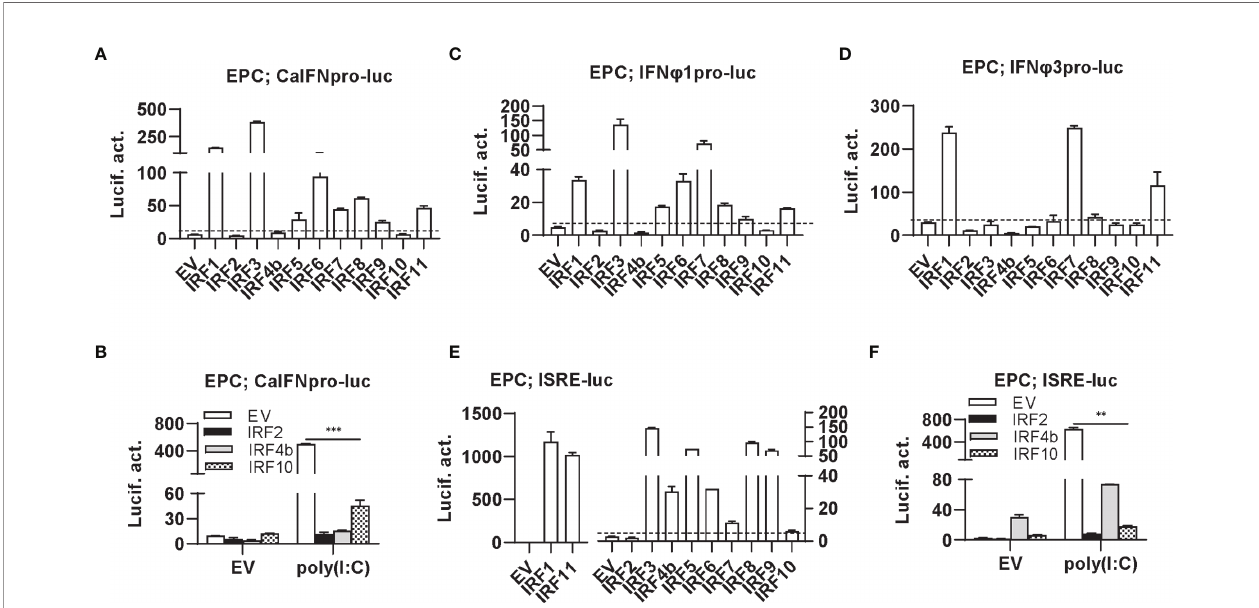
FIGURE 2 | Zebra fi sh IRF proteins are capable to regulate fi sh IFN response. (A) overexpression of zebra fi sh IRF proteins regulate the activation of crucian carp IFN promoter. EPC cells seeded in 48-well plates overnight were transfected with CaIFNpro-luc (100 ng), each of zebra fi sh IRF plasmids (100 ng) and pRL-TK (10 ng). The control cells were transfected with pEGFP-N3 (EV) instead of IRF plasmid. 30h later, cells were harvested for luciferase assays. (B) overexpression of zebra fi sh IRF2/4b/10 inhibits poly(I:C)-triggered activation of crucian carp IFN promoter. EPC cells seeded in 48-well plates overnight were transfected with CaIFNpro-luc (100 ng), each of zebra fi sh IRF2/4b/10 (100 ng), pRL-TK (10 ng) and poly(I:C) (1 ug/ml) for 30h, followed by luciferase assays. (C – E) overexpression of zebra fi sh IRF proteins regulate the activation of zebra fi sh IFN j 1 promoter (C) , IFN j 3 promoter (D) , and ISRE-containing promoter (E) . EPC cells were transfected as in (A) with IFN j 1pro-luc (C) , IFN j 3pro-luc (D) , or ISRE-luc (E) . (F) overexpression of zebra fi sh IRF2/4b/10 inhibits poly(I:C)-triggered activation of ISRE-containing promoter. EPC cells were transfected as in (B) with ISRE-luc instead of CaIFNpro-luc. The dashed line indicates the basic stimulatory effect of empty vector on IFN promoter activation. The data shown were representative of three independent experiments. (***P < 0.001, **P <